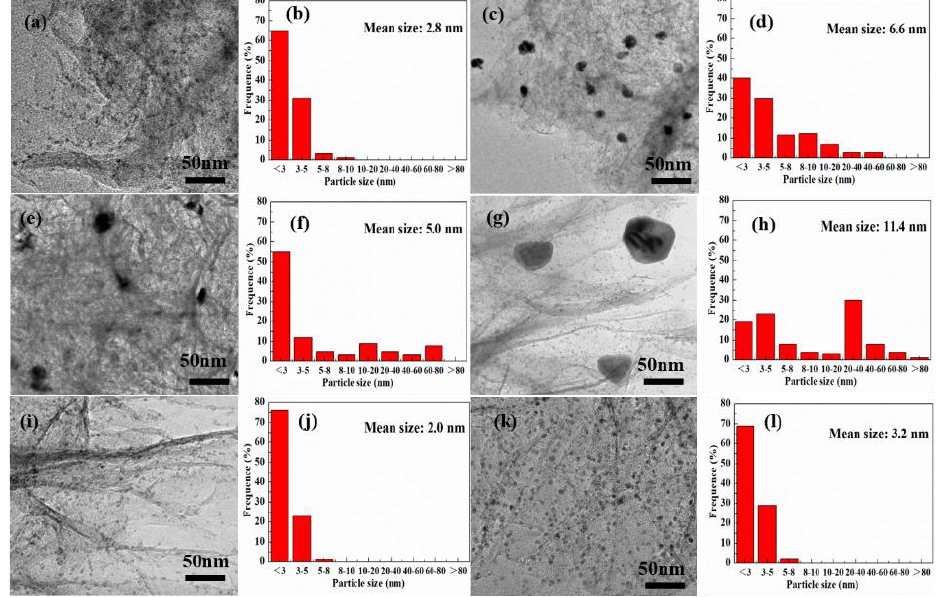
Figure 6. TEM images and the corresponding histograms of particle size distribution of the Pd/NSC ( a , b ), Pd/NSC-R ( c , d ), Pd/NSC-600 ( e , f ), Pd/NSC-600-R ( g , h ), Pd/NSC ox-2 ( i , j ), and Pd/NSC ox-2 -R ( k , l ) samples.